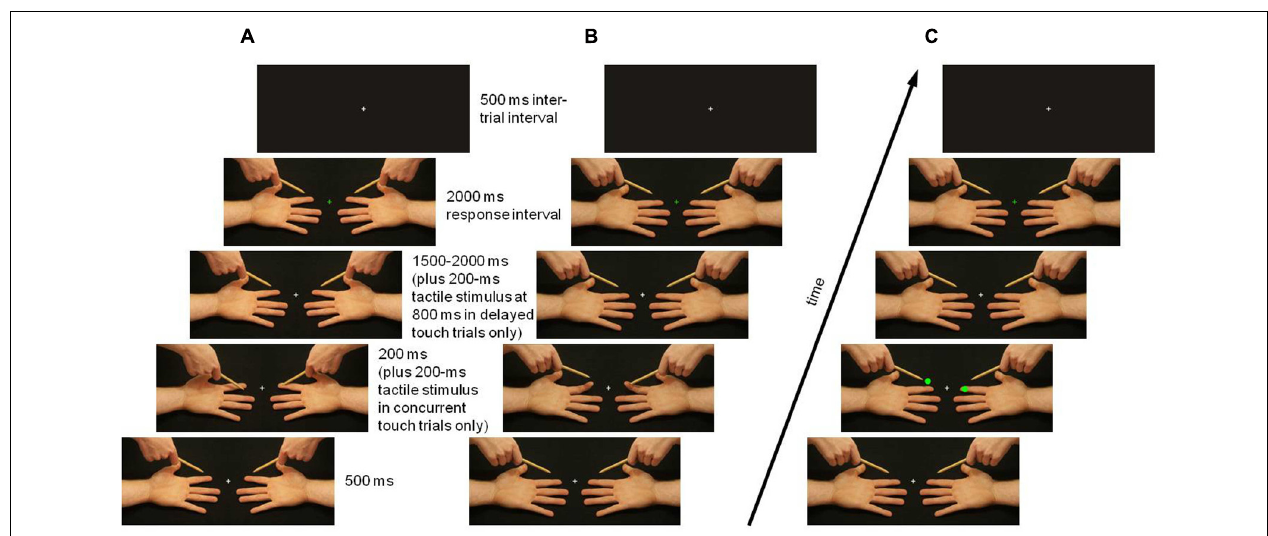
apparent motion of the pencil [passive touch trials (A) ] or finger [active touch trials (B) ] resulting in touch or no touch.Task-relevant tactile stimuli were presented to the observer’s left and right index finger pad either simultaneously with each touch/no-touch/dot image (concurrent touch trials) or 1000 ms later (in delayed touch trials). Observers fixated on a white central cross, which changed color at the end of the trial to indicate whether the intensity judgment response should be given (green) or withheld